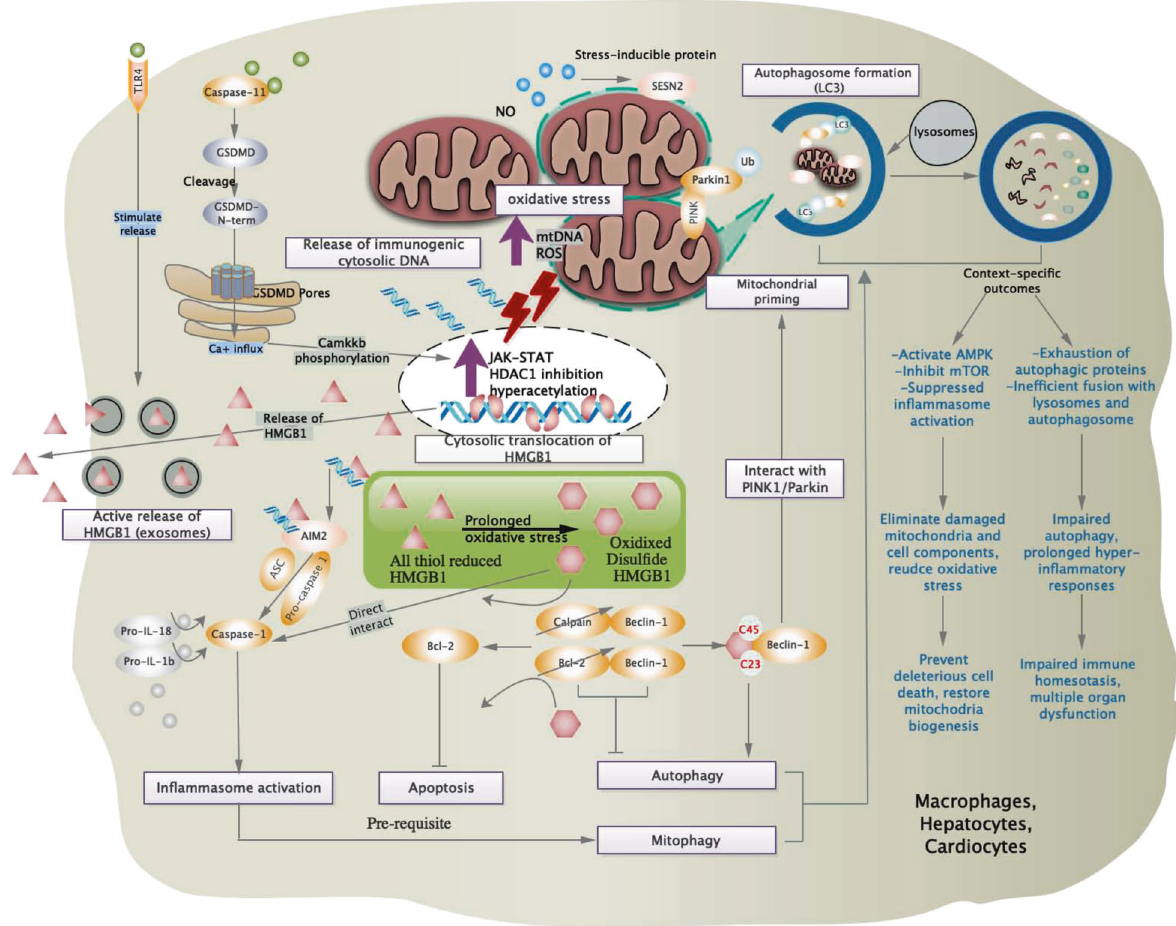
Fig. 2 Stress signaling and cell homeostasis. Intracellularly, oxidative stress-mediated redox state is pivotal to maintain host cell survival and homeostasis via cross-talks with in fl ammasome, cell death pathways, and stress-responsive proteins. Mitochondria-derived ROS and